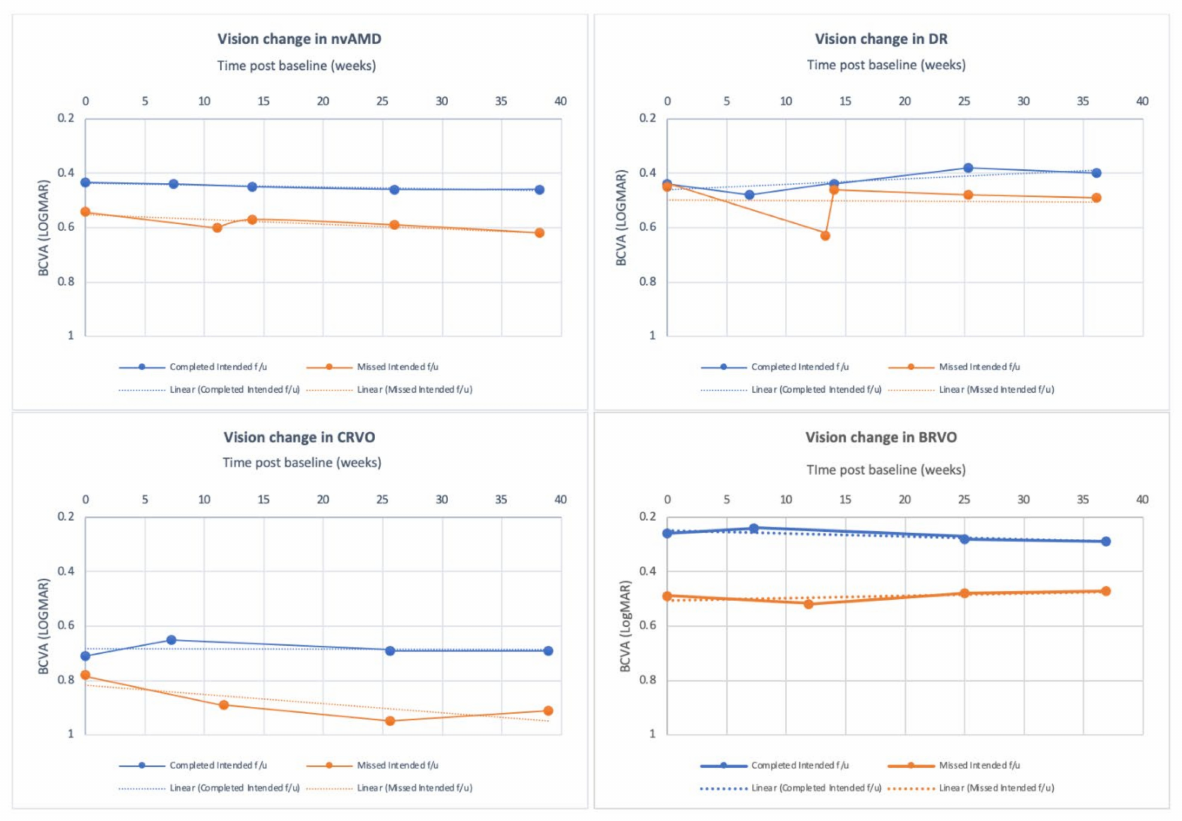
Figure 1. BCVA (logMAR) at actual f/u, at 3-month (only nvAMD, DR), 6-month and at last f/u (completed vs. missed intended f/u) by diagnosis. Abbreviations: nvAMD: neovascular Age-related Macular Degeneration; DR: diabetic retinopathy; CRVO: central retinal vein occlusion; BRVO: branch retinal vein occlusion; BCVA: best corrected visual acuity; f/u: follow up; LogMAR: Logarithm of the Minimum Angle of Resolution. LogMAR of (+) 0.1 equals loss of 5